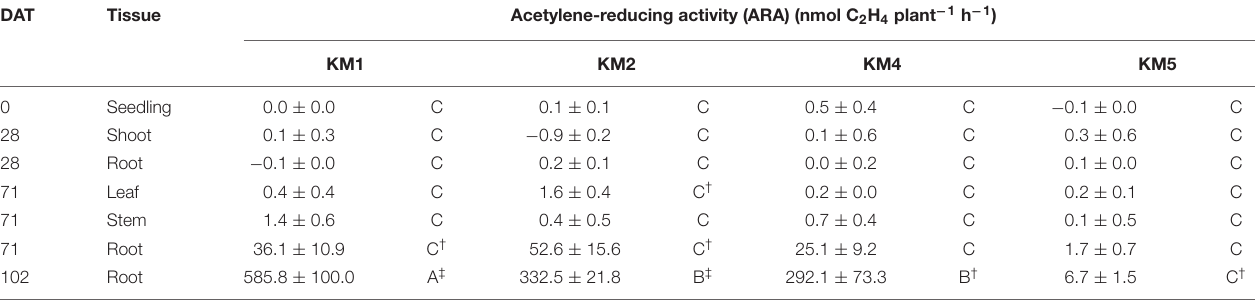
TABLE 1 | Acetylene-reducing activity (ARA) of four sorghum lines (KM1, KM2, KM4, and KM5) at each growth stage a . DAT